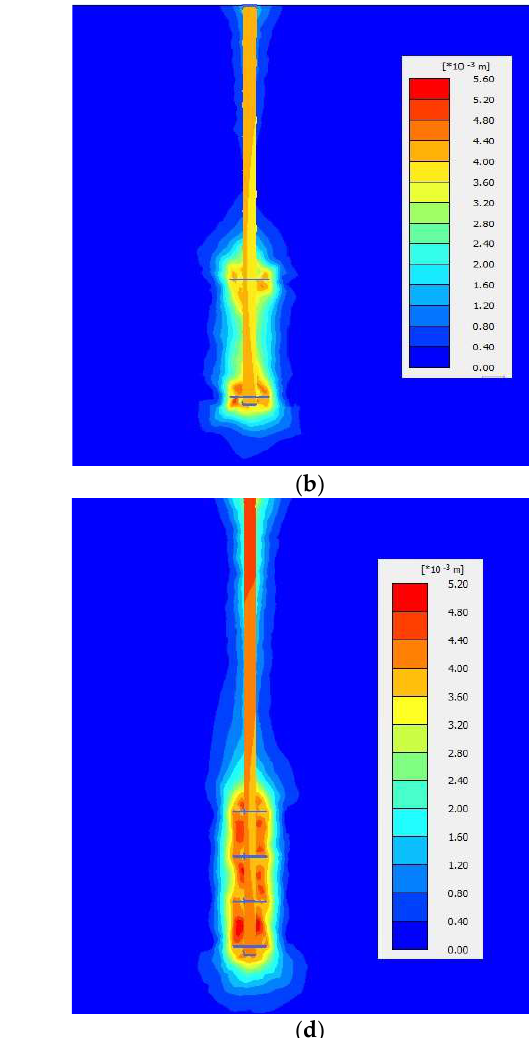
Figure 18. Variation of displacement contours with different number of plates under combined loading: ( a ) SHP-1-12; ( b ) SHP-2-8.75; ( c ) SHP-3-8.75, and ( d ) SHP-4-8.75.